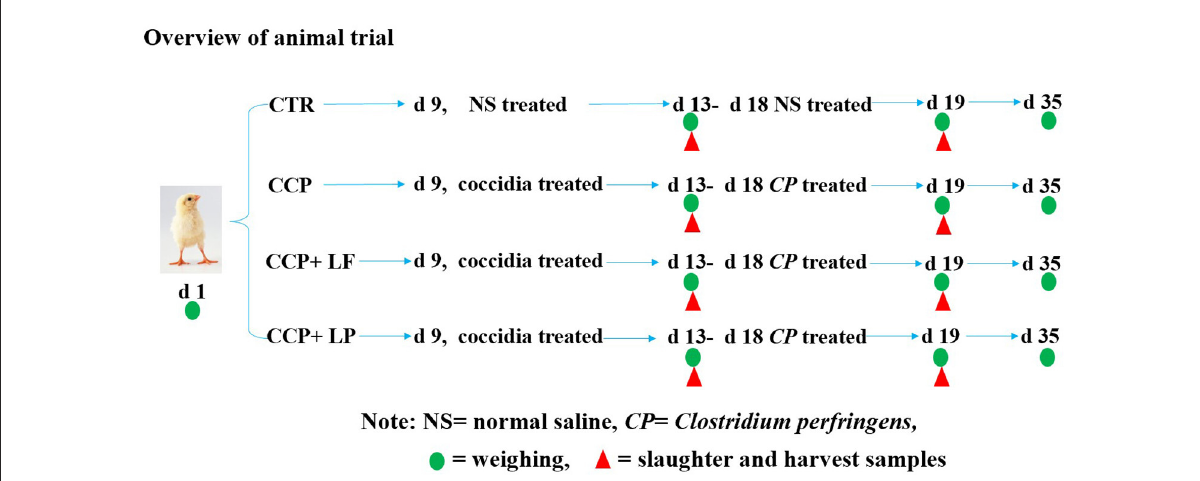
FIGURE1 The schematic diagram of the overview of the trial. All broilers were weighed to investigate the growth performance on days 1, 13, 19, and 35. Some broilers were selected to be slaughtered, and samples were collected for laboratory analysis. Among them, green circles indicate that all chickens were weighed and recorded on that day, and red triangles indicate the broiler chickens that were selected for slaughter and sampling on that